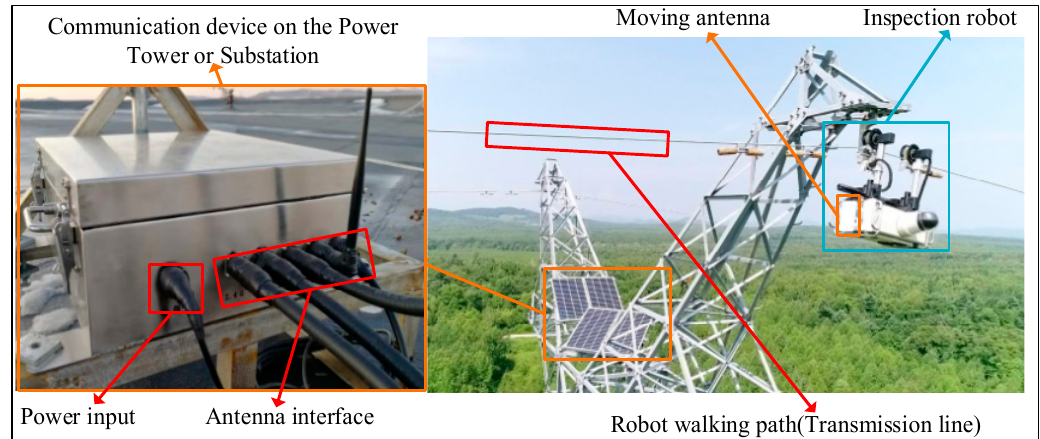
Figure 1. Multi-robot cyber physical system.